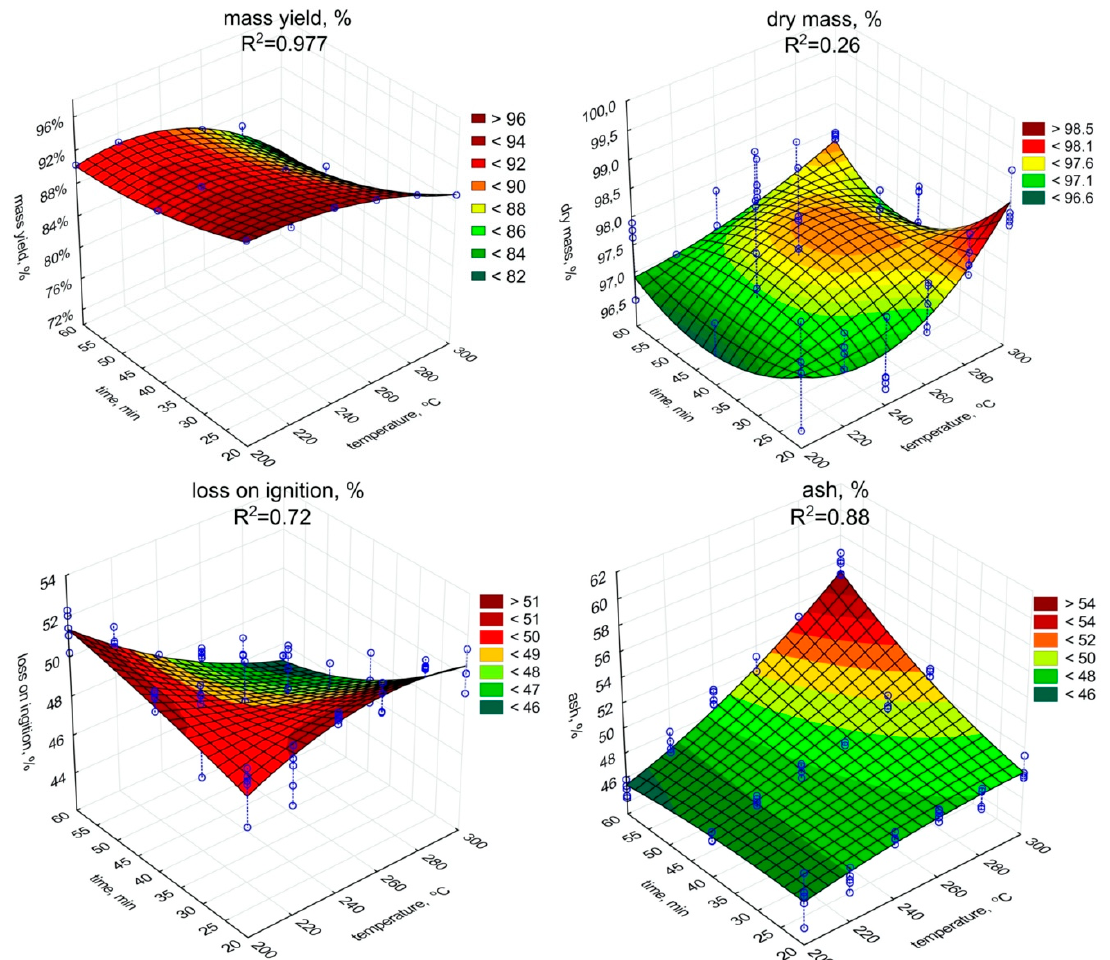
Figure 1. Mass yield, dry mass, loss on ignition, the ash content in torrefied SS in relation to process temperature, and residence time.